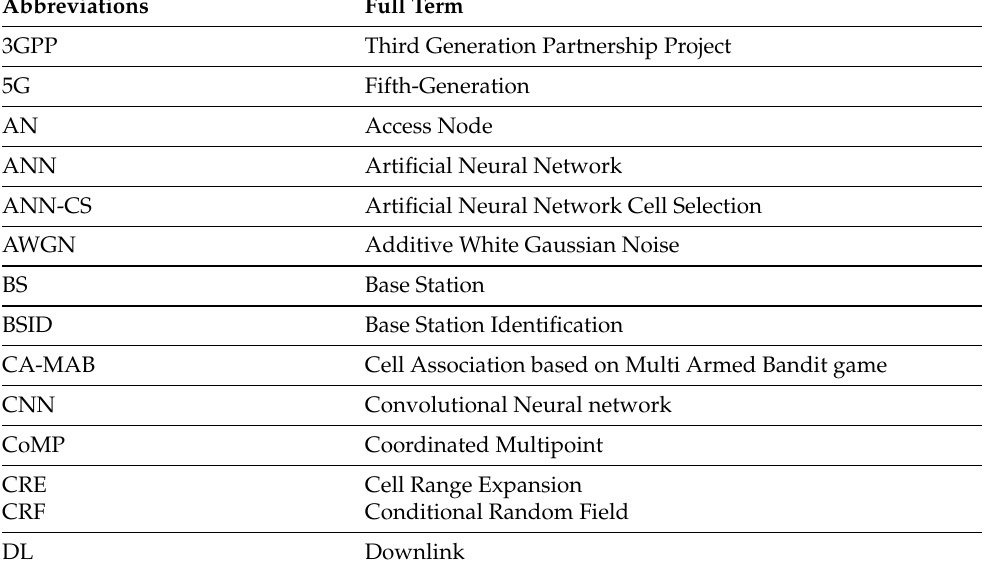
Table A1. List of